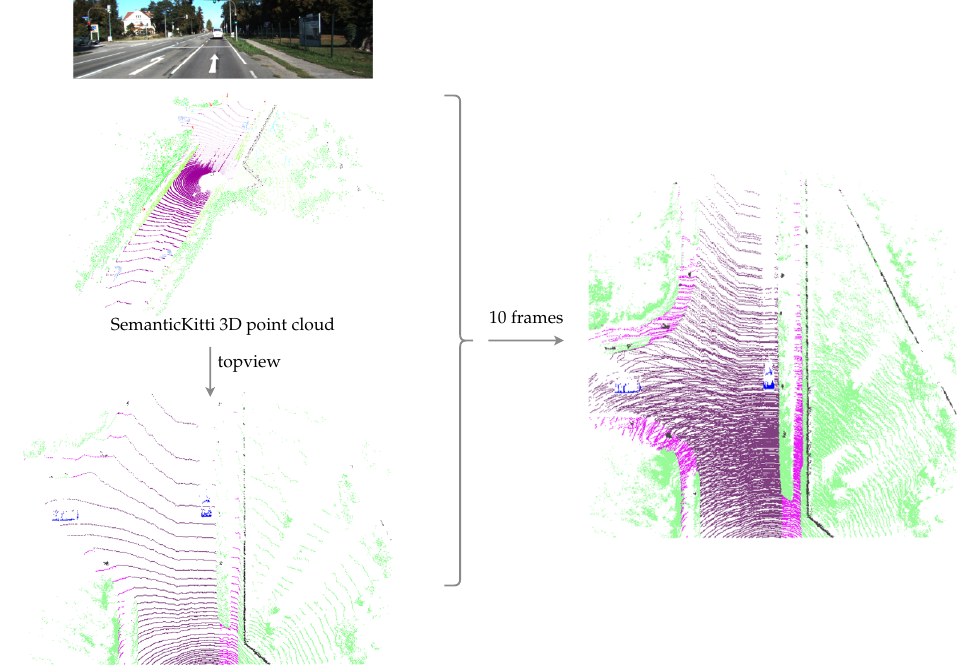
Figure 7. The generation of the ground truth used for the quantitative evaluation. Three-dimensional semantic point clouds from ten frames are merged and mapped into a top-view